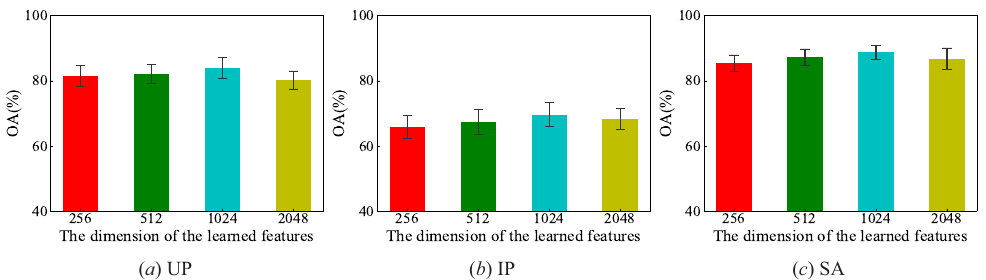
Figure 6. Relationship between the dimensions of the learned features and the overall classification accuracy in three